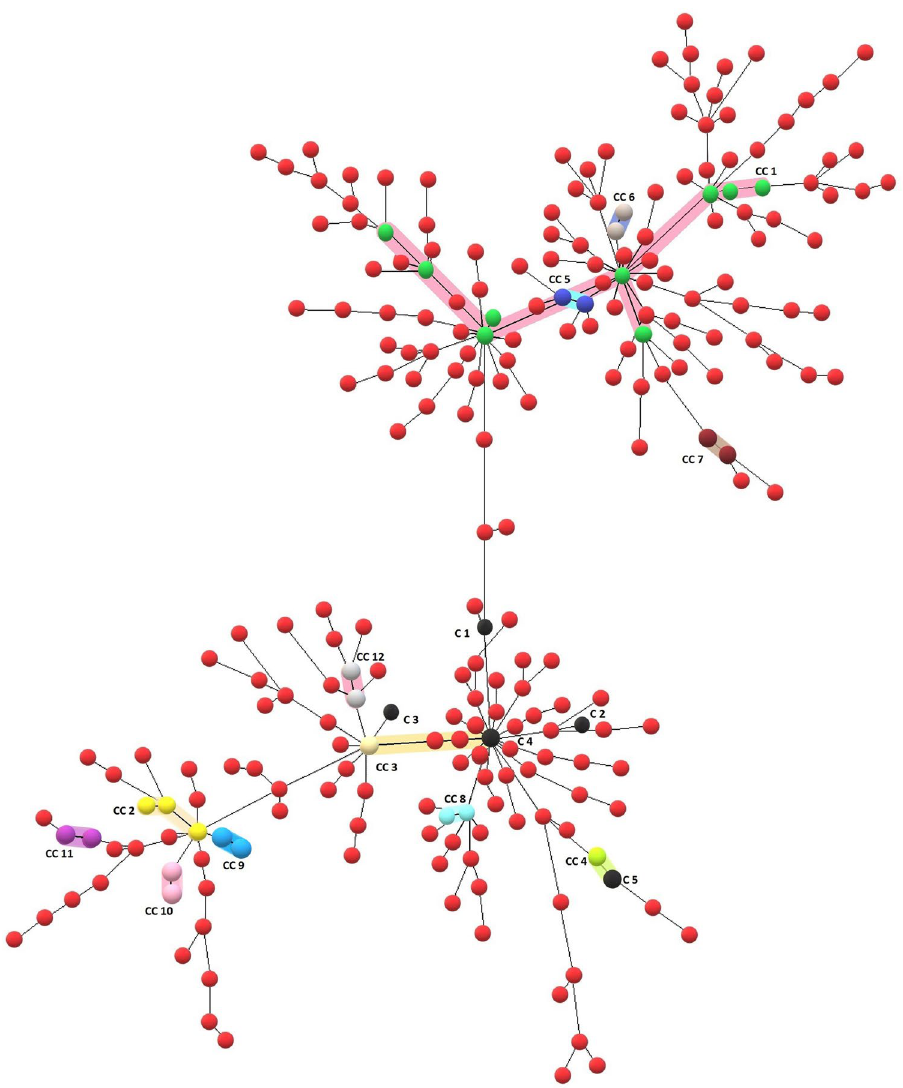
Figure 3. A Minimum Spanning Tree (MST) depicting relationships among 249 Beijing isolates from Sikkim, India based on 24-loci MIRU-VNTR data. This tree shows the clustering of MTBC isolates based on a final match of 24-loci MIRU-VNTR profiles (10 isolates represented by 5 black dots) and clusters based on Single Locus Variant (SLV-1) (i.e. these clusters of isolates which differ from each other by the single difference in 24-loci MIRU-VNTR profile). The largest Clonal Complex (CC1) comprisesnine isolates shown by green dots and highlighted in pink colour. This MST was developed using the MIRU-VNTRplus web tool (https:// www. miru- vntrp lus. org) and the figure was enhanced using Microsoft Paint (https:// ms- paint. en. softo nic.